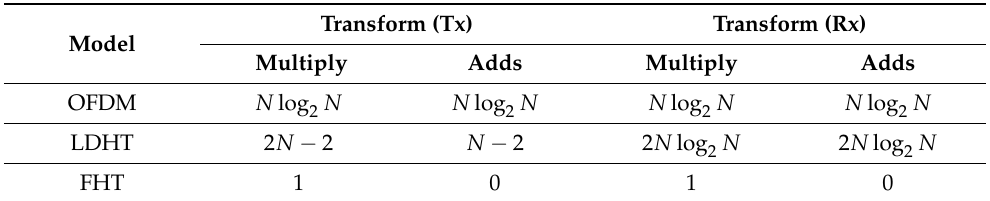
Table 1. Complexity comparison of LDHT [24], OFDM and proposed modified receiver-side FHT (labelled